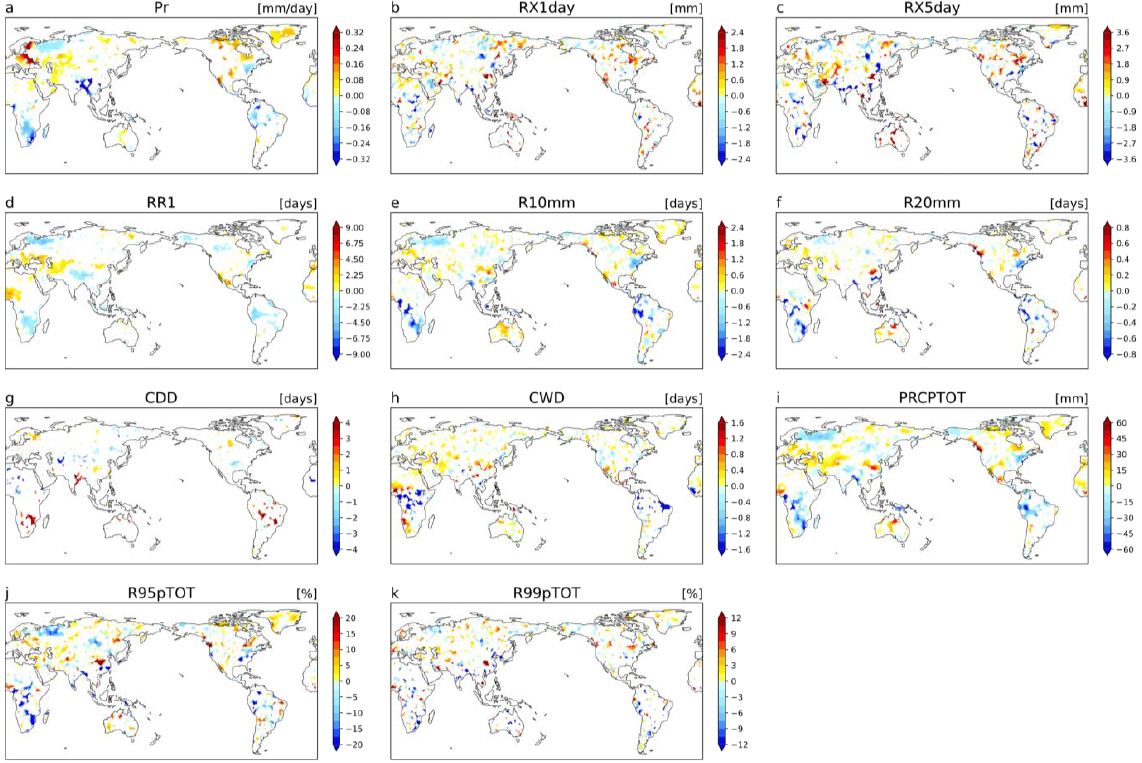
Figure 2. Similar to Figure 1 but for multi-model ensemble spatial patterns of the impact of land use change on future precipitation extremes. ( a ) mean precipitation, ( b ) RX1day, ( c ) RX5day, ( d ) RR1, ( e ) R10mm, ( f ) R20mm, ( g ) CDD, ( h ) CWD, ( i ) PRCPTOT, ( j ) R95pTOT, ( k ) R99pTOT.